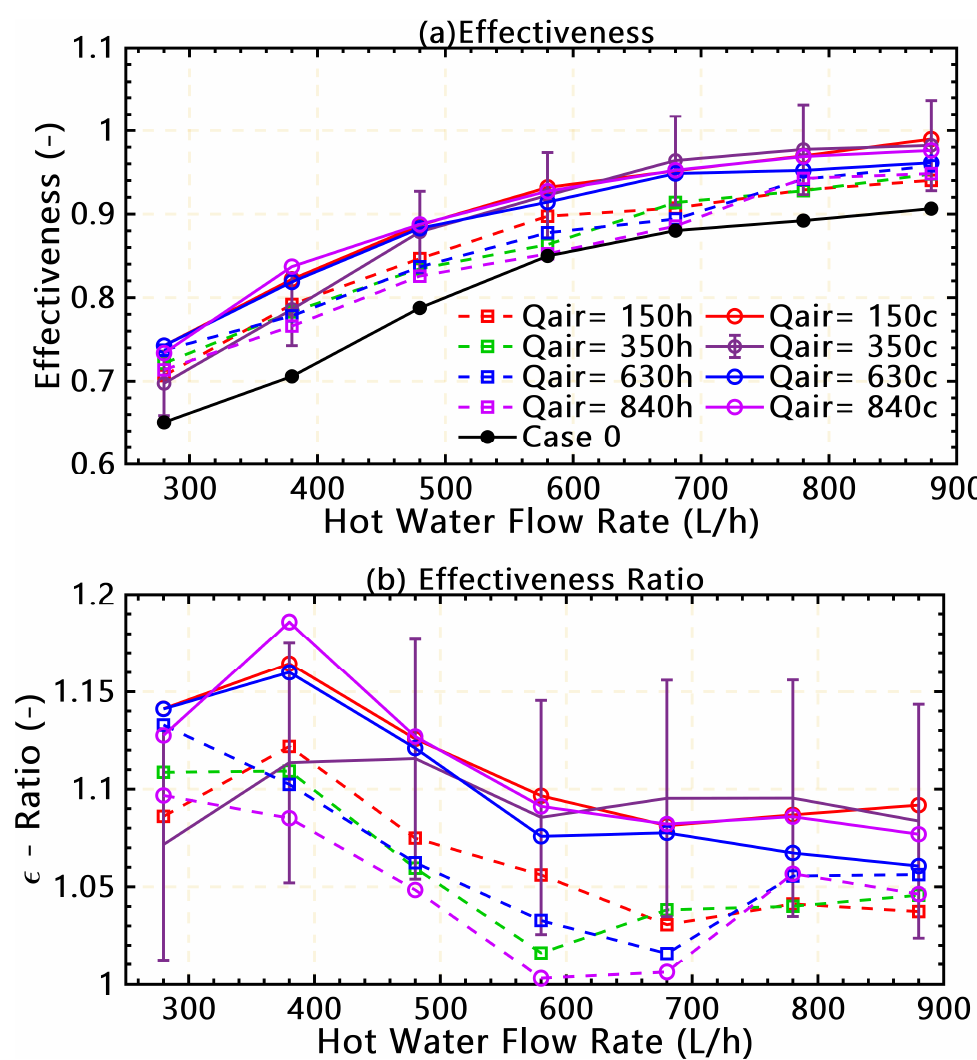
Figure 6. ( a ) Effectiveness and ( b ) ε − Ratio vs. hot water flow rates at different operating conditions for single-phase, and two-phase flow of ABI into CWS and HWS.